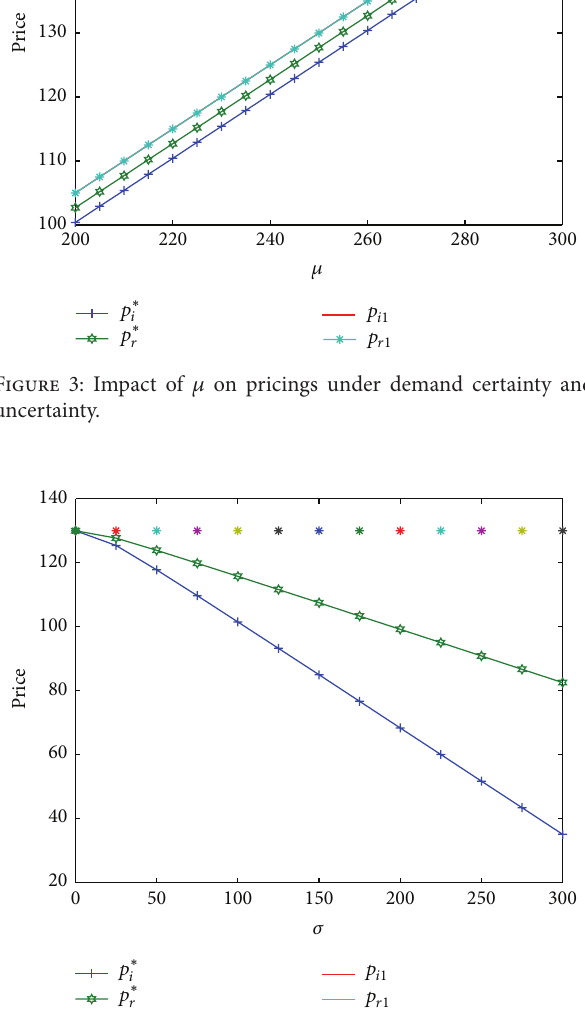
Figure 4: Impact of 𝜎 on pricings under demand certainty and